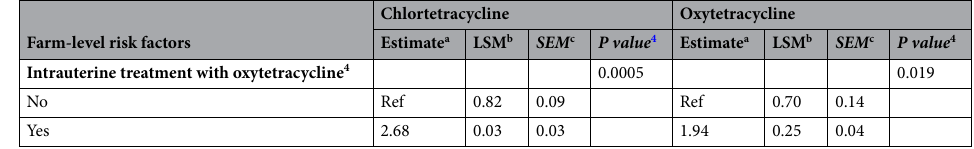
Table 5. Association of farm-level management of using oxytetracycline as an intrauterine infusion as the most common drug for the treatment of metritis and farm-level prevalence of AMR to tetracycline drugs in intrauterine E. coli. a Parameter estimate for the multivariate model evaluating resistance to the referred drug. b Least-square means (LSM) of farm-level prevalence of intrauterine E. coli resistant to the referred drug. c Standard error of the means (SEM) for the LSM. 4 P value from analysis comparing farm-level prevalence of AMR between farms for the referred drug, adjusted using